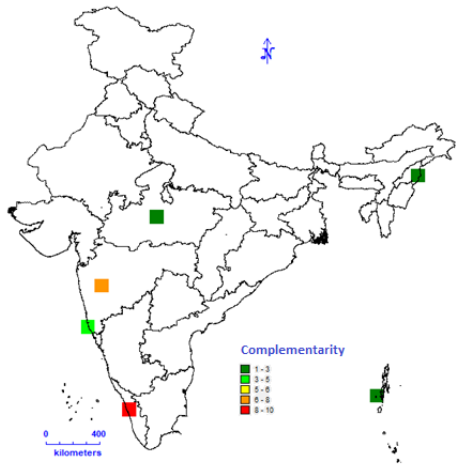
Figure 6. Species richness for 19 taxa of wild Vigna in 70 × 70 km grid cells.